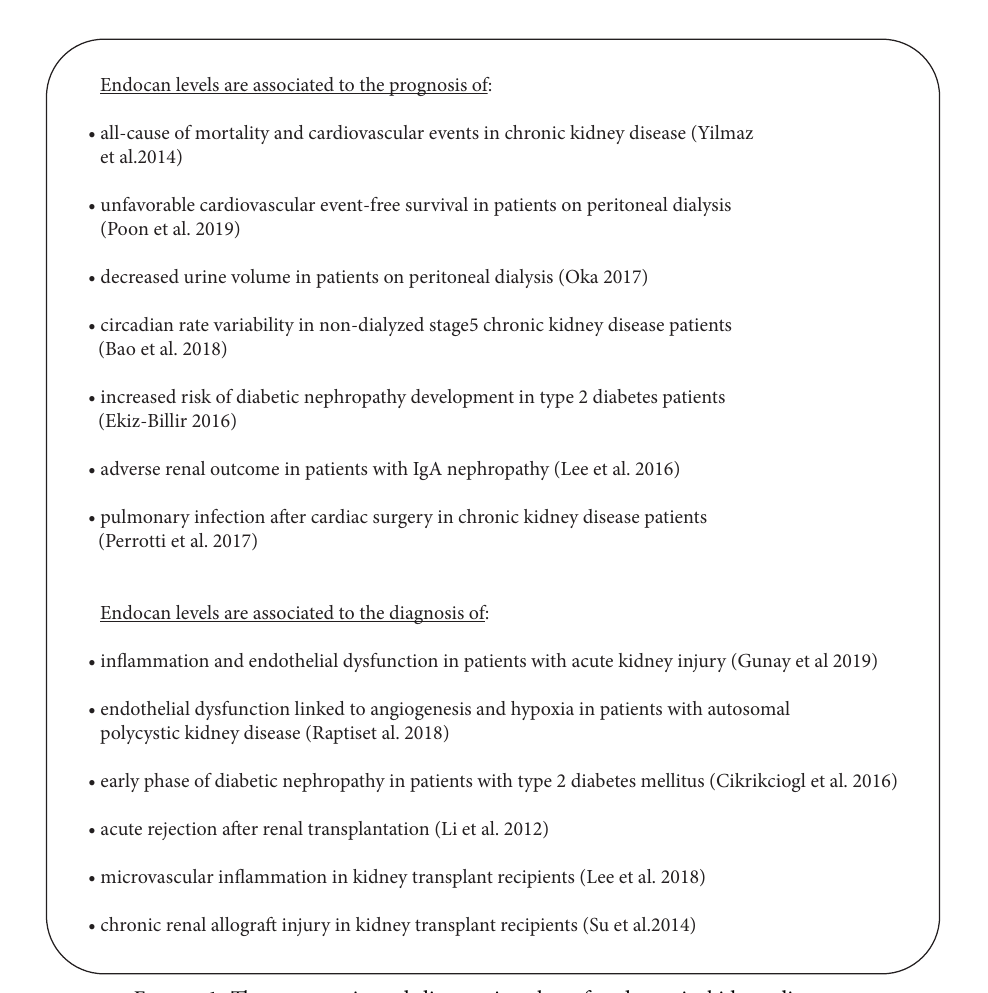
Figure 1: The prognostic and diagnostic value of endocan in kidney